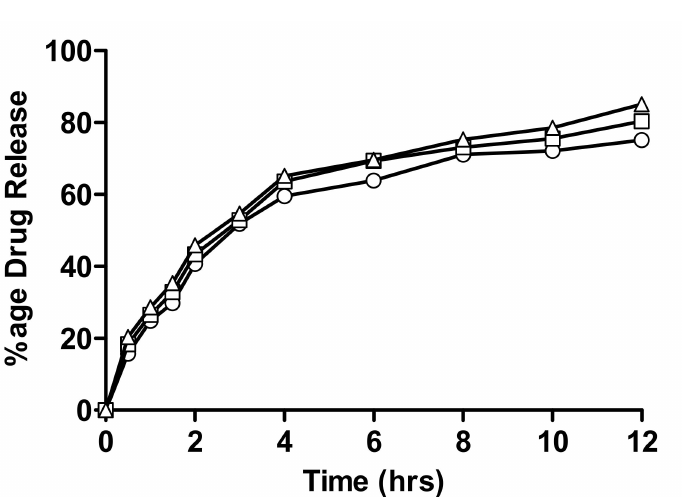
Figure 8. Percentage release of nicorandil from formulations having varying linseed mucilage concentration; ( (cid:35)